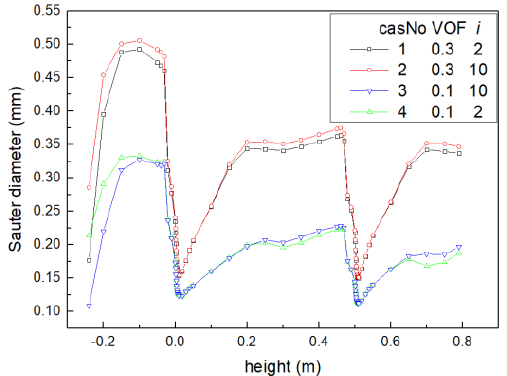
Figure 8. Sauter averaged diameters along flow direction.